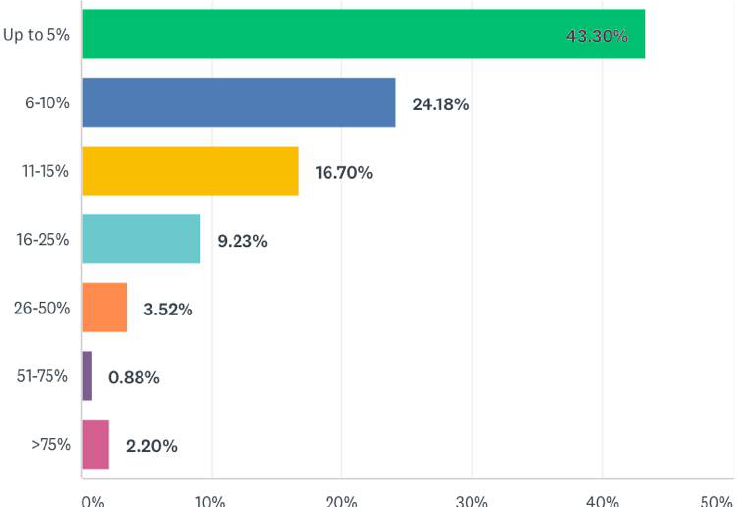
Figure 7. Amount U.S. participants are willing to pay—sustainable tourism. Note: responses to the